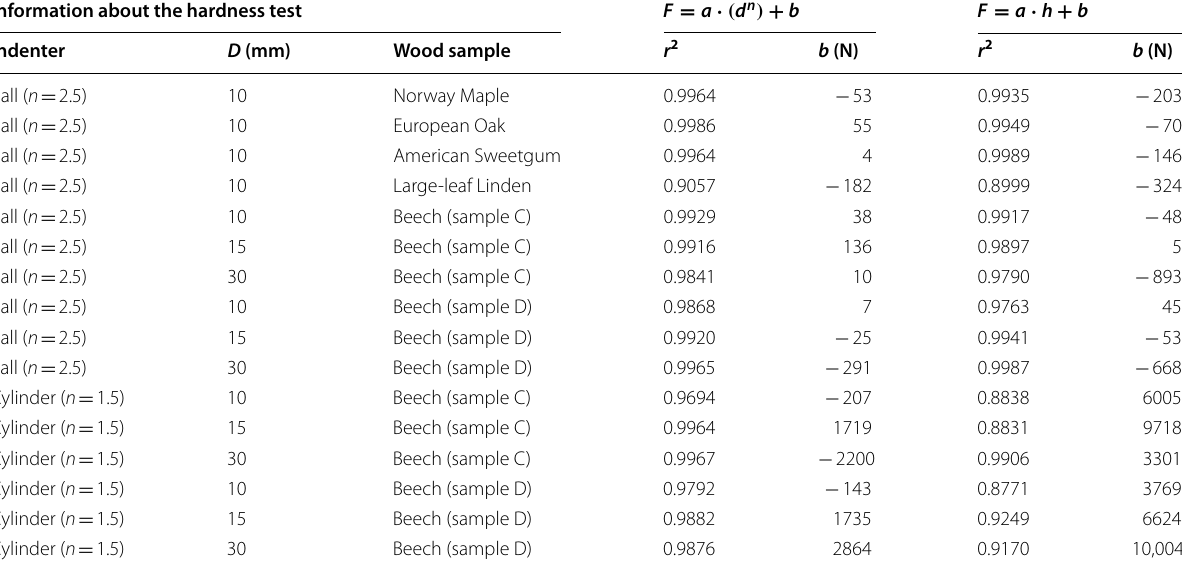
Table 2 Comparison of linear correlations for Meyer law and Brinell and Monnin measures Information about the hardness